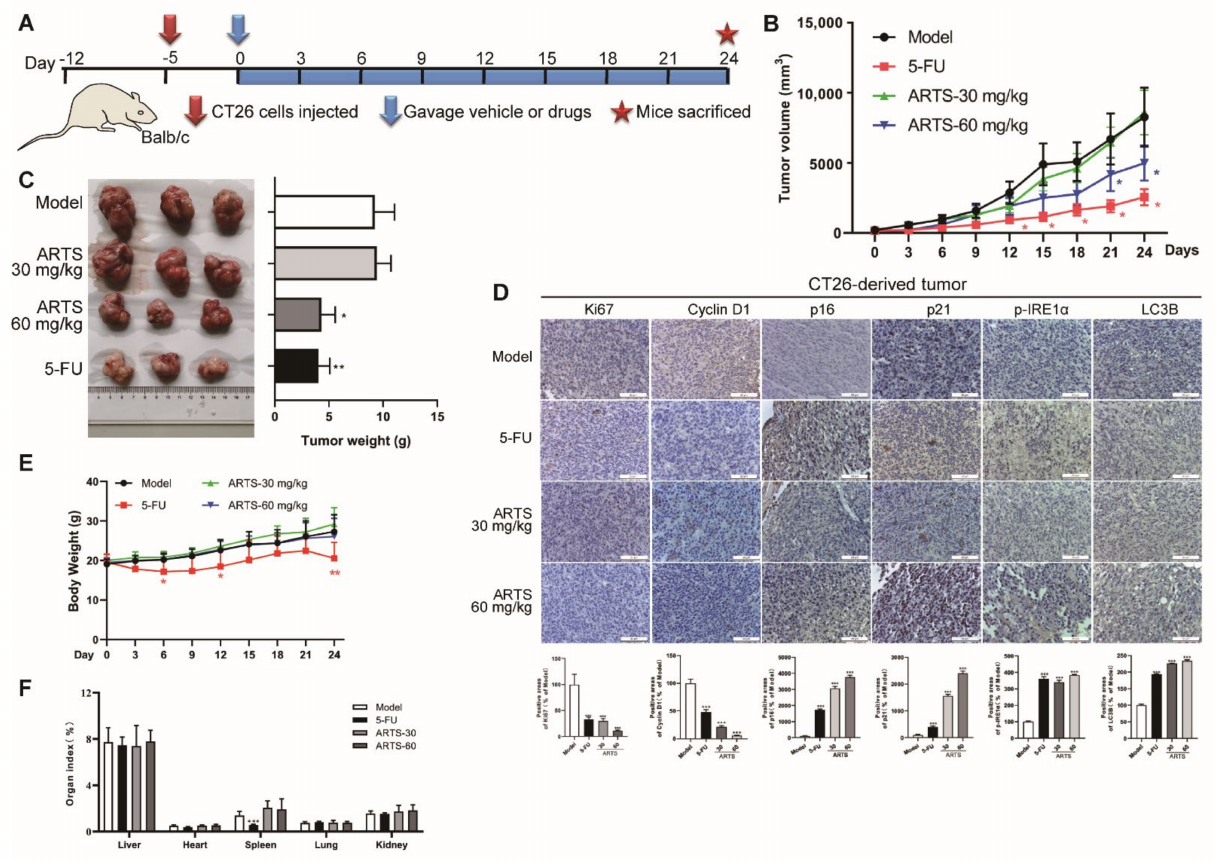
Figure 8. Artesunate inhibited the growth of CT26-derived tumor in vivo. ( A ) Experimental timeline of CT26-derived tumor model in balb/c mice. Balb/c mice were injected CT-26 cells (1 × 10 5 cells for each mouse) subcutaneously to establish the CT26-derived tumor model. Tumor-loaded mice were gavaged with artesunate at 30 mg/kg or 60 mg/kg for 24 days. Body weights and tumor volumes were recorded every three days. ( B ) Curve of tumor volume. ( C ) Tumor weight. Tumor tissues were collected and weighted after treatment. ( D ) Immunohistochemical images of Ki67, Cyclin D1, p16, p21, LC3B, and p-IRE1 α . Immunohistochemistry assay was performed using a SABC-POD staining kit. ( E ) Curve of body weight. ( F ) Organ indexes. Lung, heart, spleen, liver, and kidney were collected and weighted to calculate the organ indexes after treatment. * p < 0.05, *** p < 0.001 vs. Model group. Data were shown as mean ±